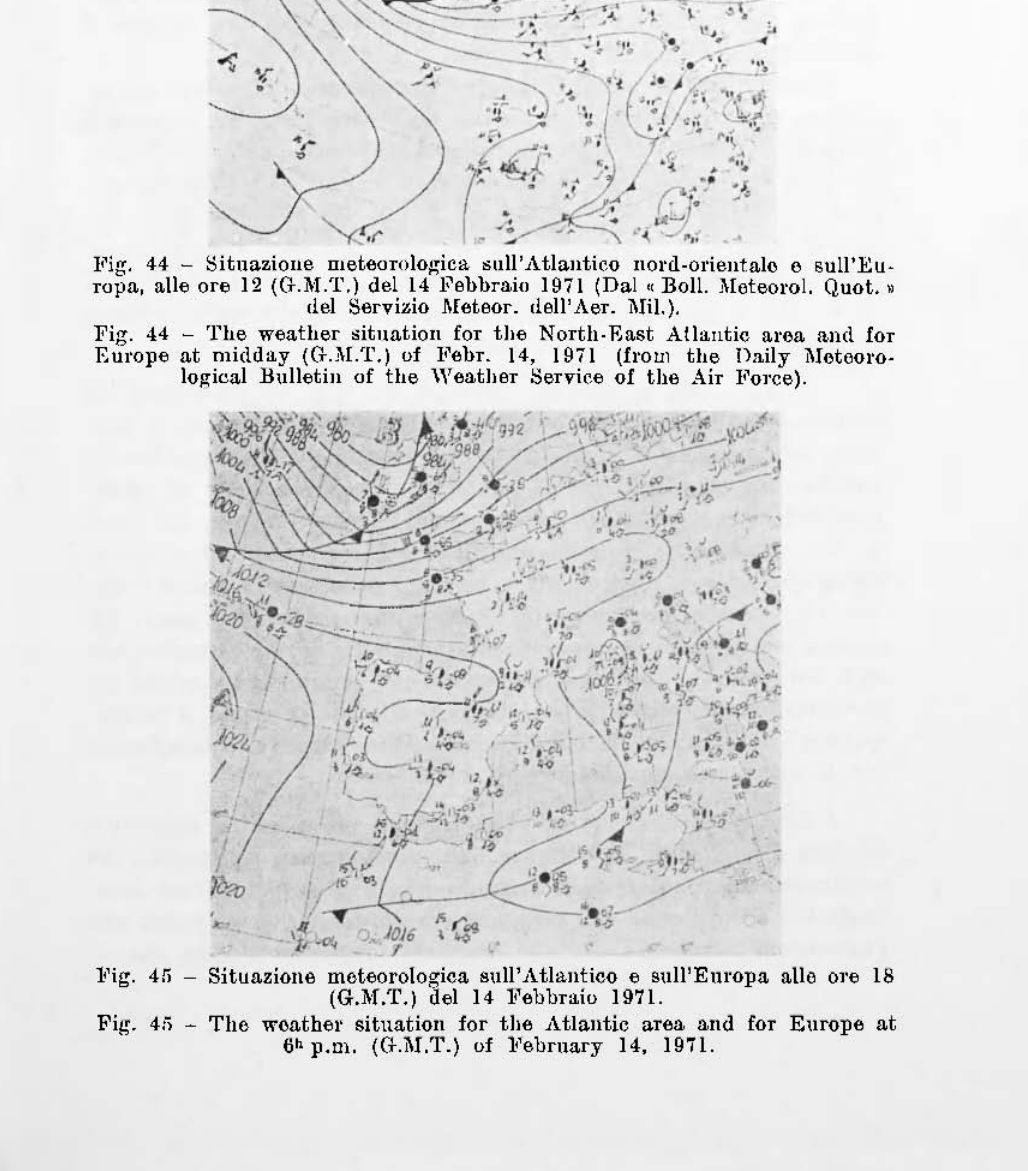
Fig. 4:; ~ The wcather situatioli for the Atlantic area alid far Europe at 6h p.m. (G.M.T.) of l<'ebruary 14,